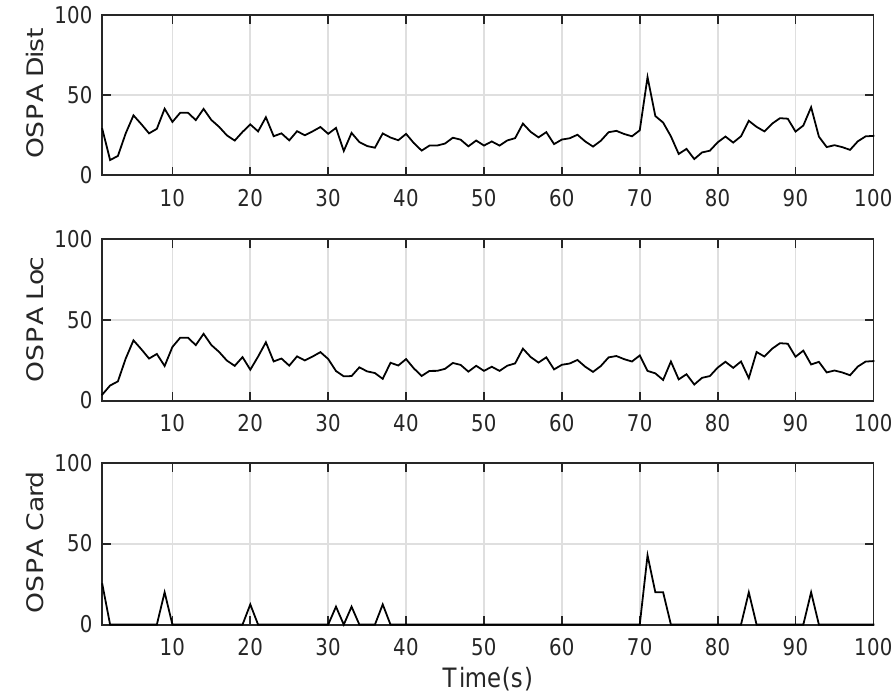
Figure 9. The OSPA distance by Gibbs GLMB